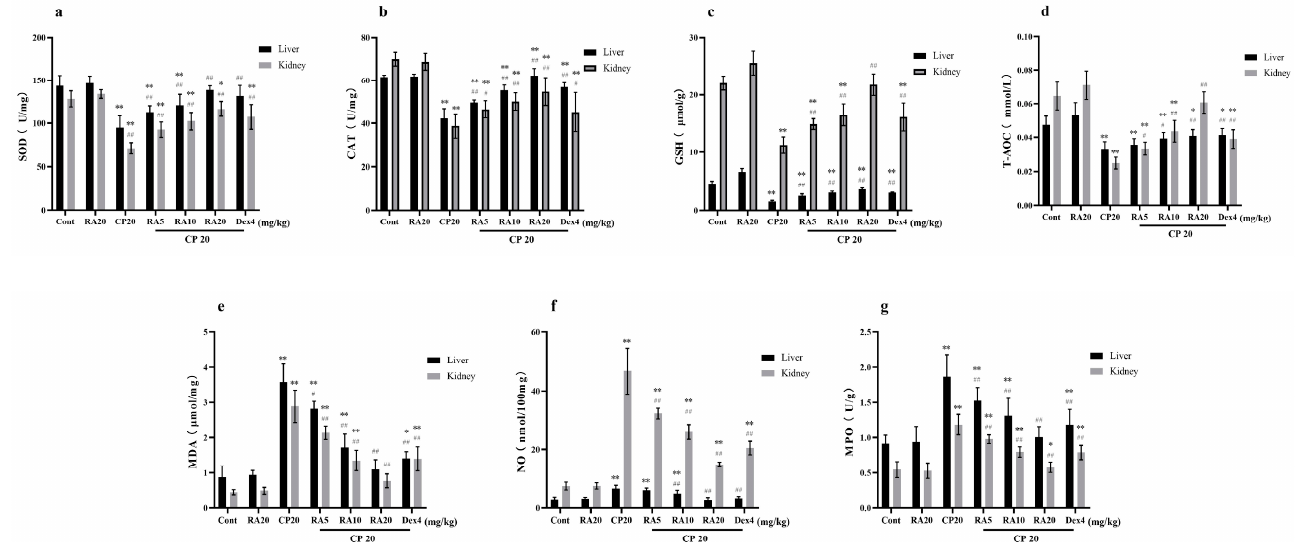
Figure 4. The effect of RA on the expression levels of SOD, CAT, GSH, T-AOC, MDA, NO, and MPO in the liver and kidney of mice induced by CP. The liver and kidney tissues were homogenized, the supernatant was taken, and the antioxidant capacity of the liver and kidney tissues was detected by ELISA ( a – g ). These experiments were repeated three times. * and # denote significant differences ( p < 0.05) and ** and ## denote highly significant differences ( p < 0.01) compared with the control and CP model groups,